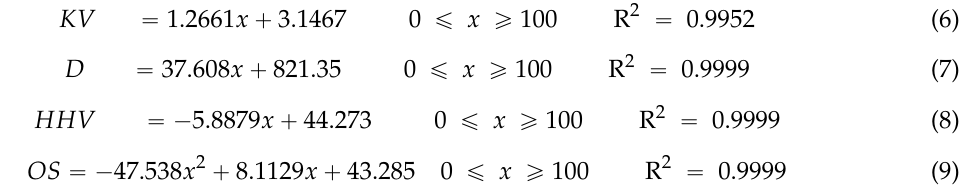
( b ) ( c ) ( d ) Figure 5. Effect of macadamia biodiesel–diesel blending on ( a ) KV ; ( b ) D ; ( c ) higher heating value ( HHV ); and ( d ) OS .